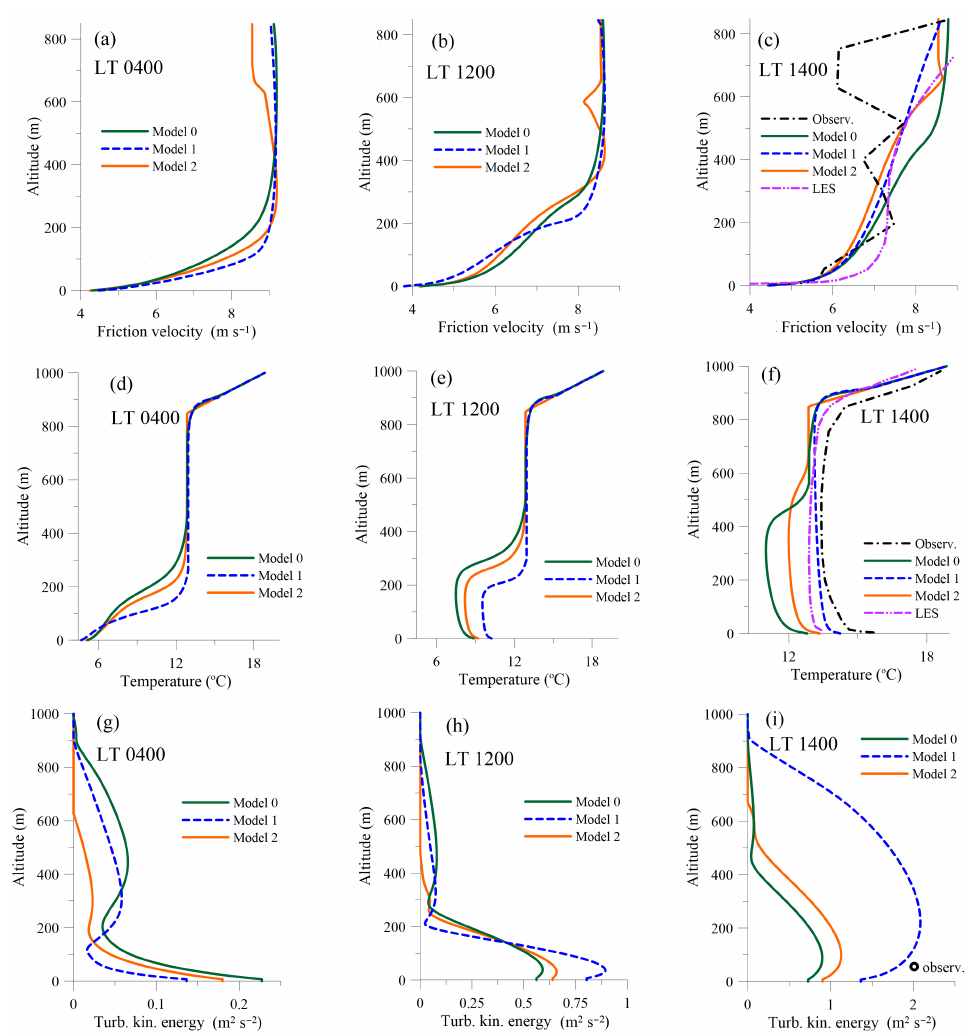
Figure 7. Vertical profiles of flow variables at different time instants: ( a – c ) Wind speed. ( d – f ) Potential temperature. ( g – i ) Turbulence kinetic energy. Black circle with in subplot ( i ) corresponds to a measured TKE value reported in